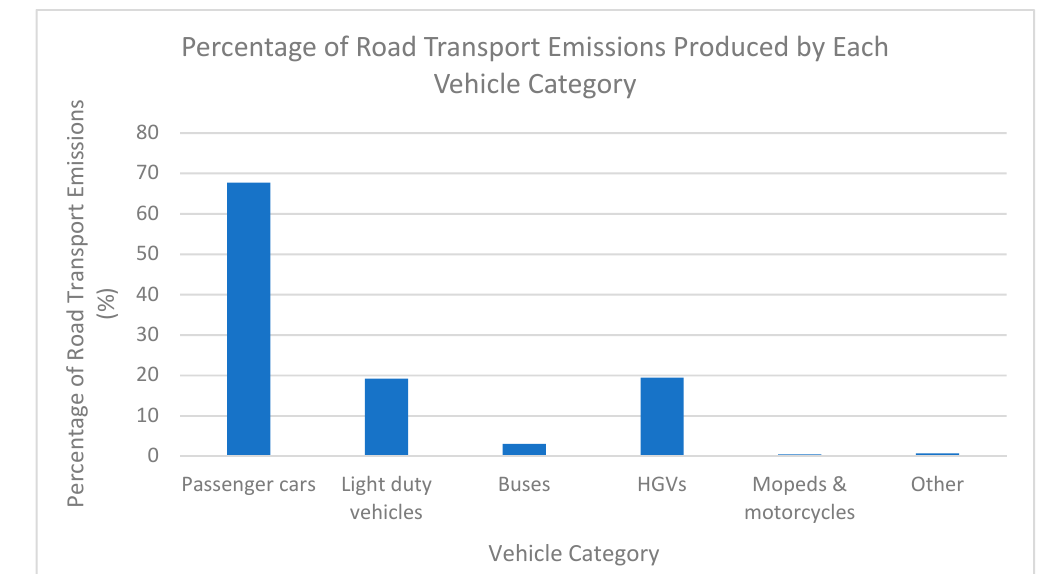
Figure 1. Chart displaying the proportion of road transport emissions for each vehicle category. Source of data: [23].